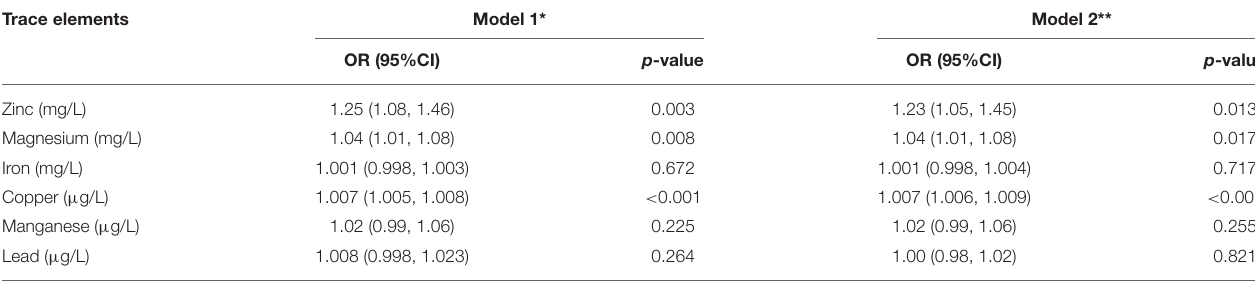
TABLE 2 | Binary logistic analysis between blood trace elements and presence of thyroid nodules.